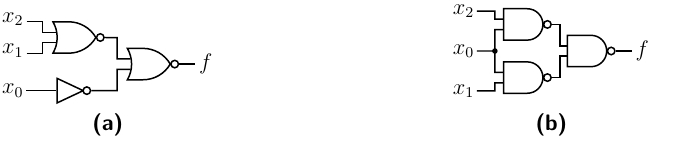
Figure 3: Two different circuits with the minimum gate depth for implementing f = x 0 ∧ ( x 1 ∨ x 2 ) used in Example